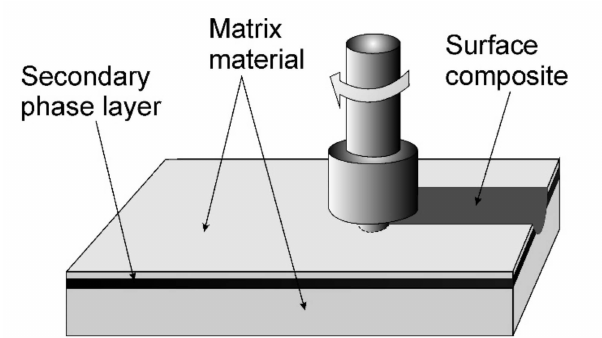
Figure 8. Diagram of sandwich method (authors’ own